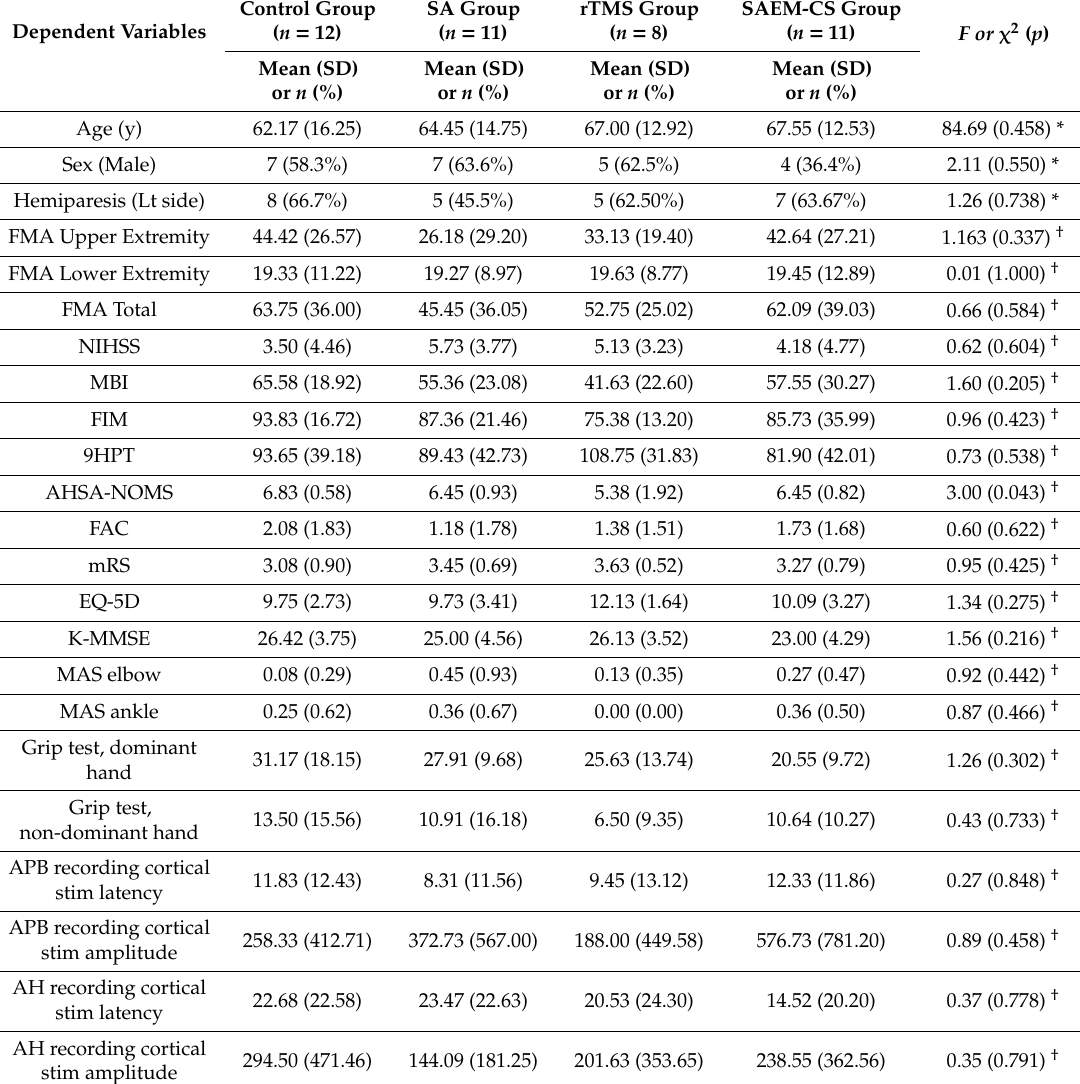
Table 2. Homogeneity tests for baseline demographic characteristics and study variables of 42 patients with cerebral